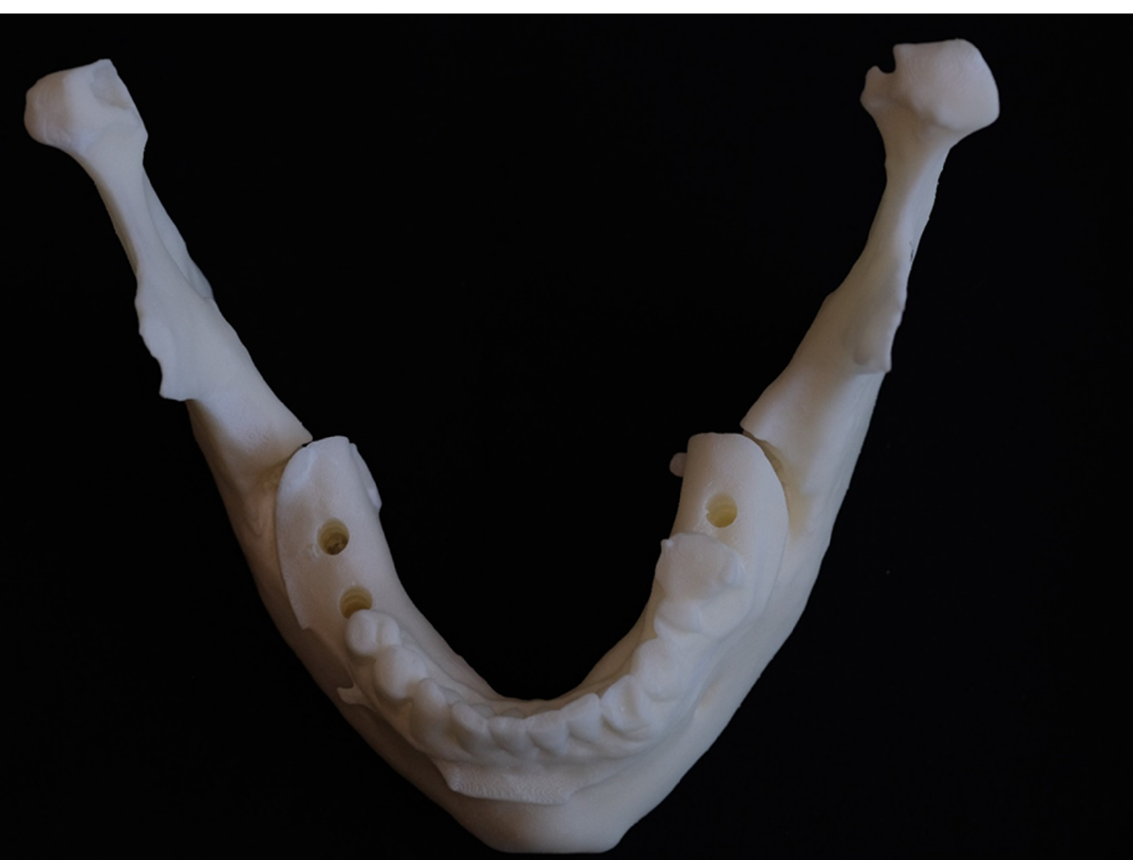
Figure 4. The 3D printed model used in the research.